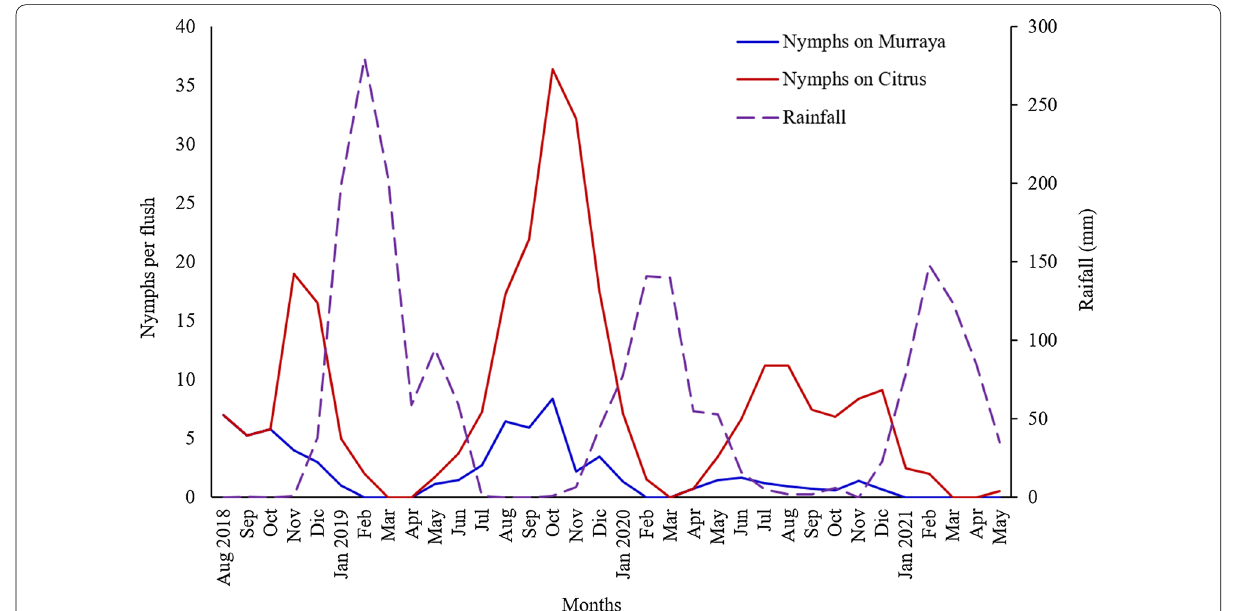
Fig. 1 Fluctuation of Diaphorina citri nymphs on both host plants and rainfall. Period August 2018–May